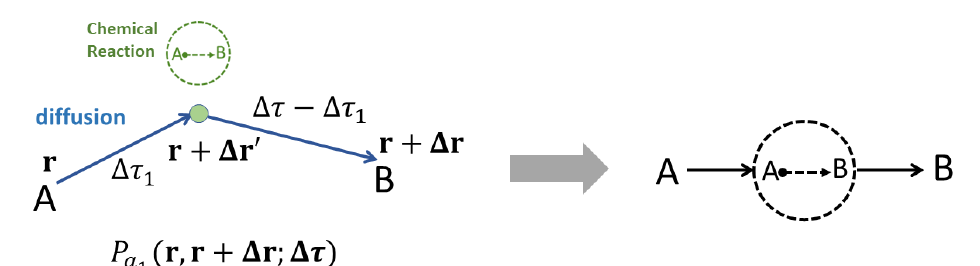
Figure 2. The left panel shows more information about the b 1 diagram of Figure 1b, which indicates that in this process, an A molecule will firstly diffuse from r to r + ∆ r (cid:48) within ∆ τ 1 , then turn into the B molecule through chemical reaction (green dot) at the position r + ∆ r (cid:48) , and finally B diffuses to the position r + ∆ r within ∆ τ − ∆ τ 1 . The probability of this process is denoted as P b which is obtained by path integrating over all possible trajectories r → r + ∆ r (cid:48) and r + ∆ r (cid:48) → r + ∆ r and by integrating over the intermediate variables ∆ r (cid:48) and ∆ τ 1